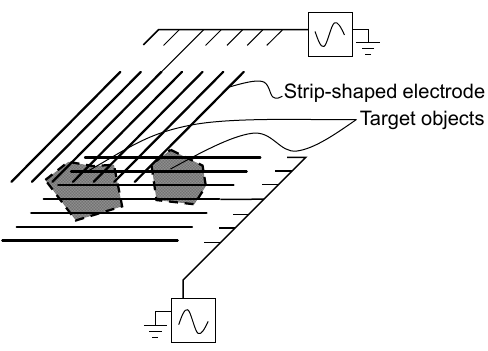
Figure 1. Conceptual illustration of the manipulation technique in this study.